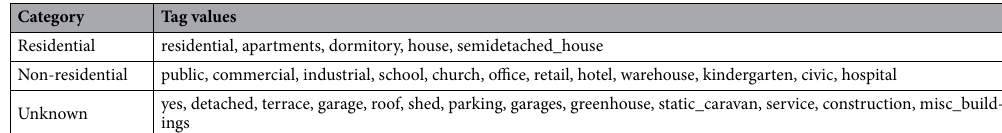
Table 3. OSM building type meta-categories for Fairfax, Mecklenburg, and City of Boulder.